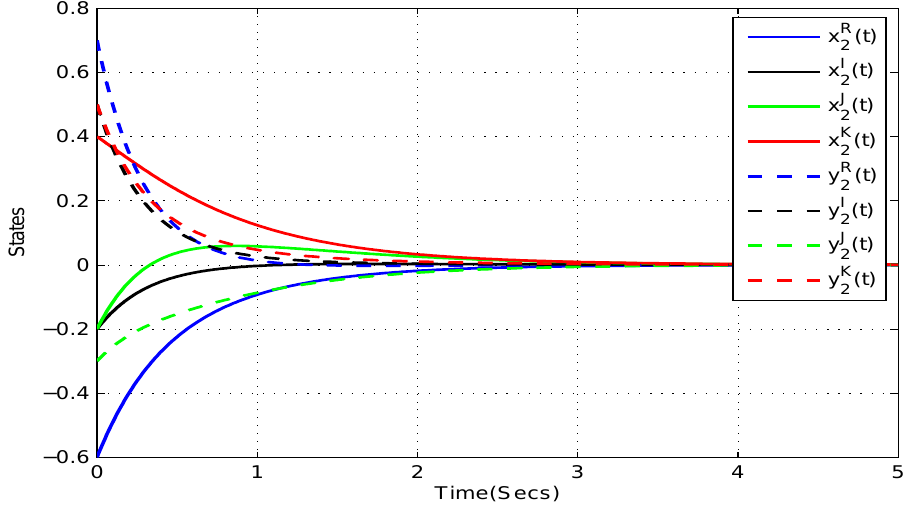
Figure 2. An illustration of the time responses with respect to the real-imaginary parts pertaining to the ( t ) , x I ( t ) , x J ( t ) , x K ( t ) , y R ( t ) , y I ( t ) , y J ( t ) , y K ( t ) in Example states of x R 2 2 2 2 2 2 2 2